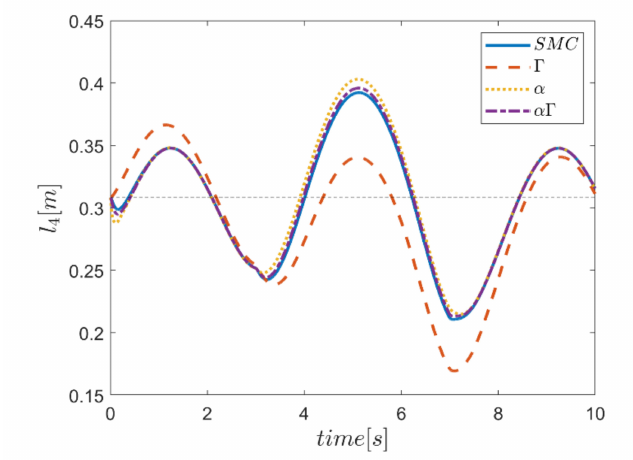
Figure 59. Comparison of the length of the fourth